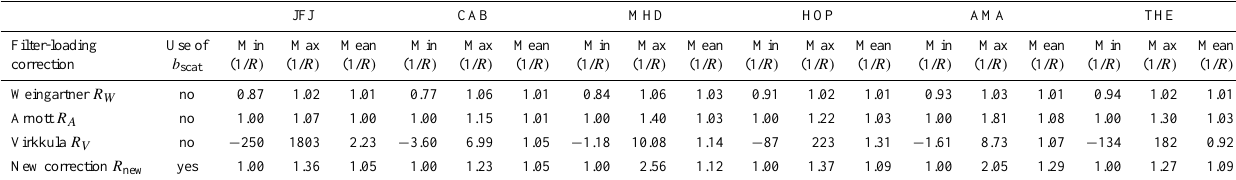
Table 3. Use of the scattering coefficient, minimum, maximum and mean of 1/ R values, for all four filter-loading corrections and for the four measuring stations. For the Weingartner correction f =1.025, f =1.1, f =1.05, f =1.025, f =1.025 and f =1.2 were taken for JFJ, CAB, MHD, HOP, AMA and THE datasets, respectively. R values were taken at λ =660nm for multi-wavelength AE (JFJ, CAB, AMA and THE). JFJ CAB MHD HOP AMA THE Filter-loading Use of